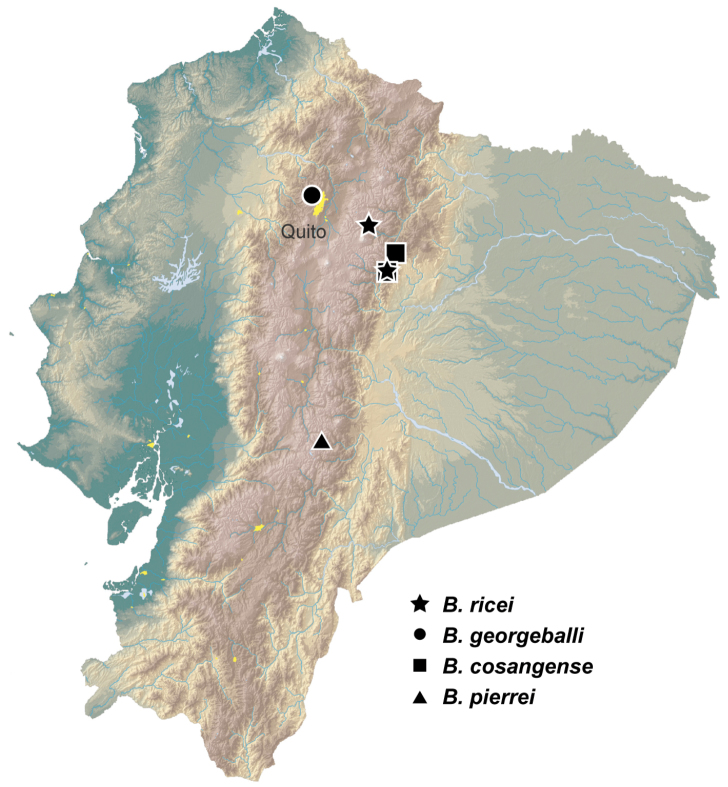
Geographic distribution of known members of the georgeballi species group in Ecuador. Base map modified from Chirico and Warner (2005).